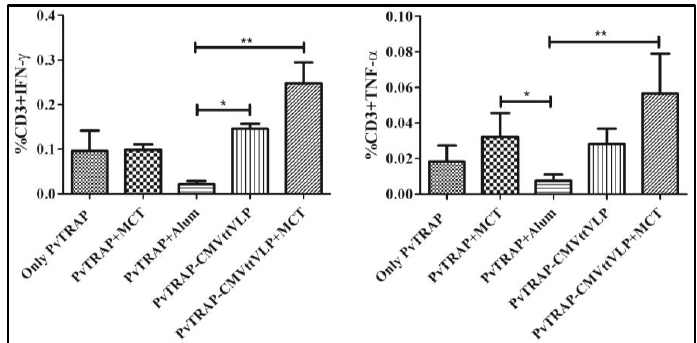
Figure 6. Analysis of T cell response by detecting IFN-γ and TNF-α. The frequencies of IFN-γ and TNF-α T cell responders were quantified by ICS as previously described, using splenocyte stimulated for 12 h in the presence of PvTRAP-specific peptide. The graphs show means and standard errors of the mean (SEM) of five mice per group. Data were analysed with either FlowJo or GraphPad Prism software applied to assess the means of five groups by one-way analysis of variance (one-way ANOVA); and an unpaired t test was employed to compare two normally distributed groups. **, p value < 0.001; *, p value <